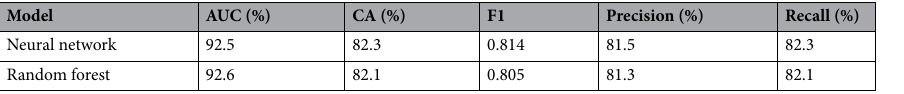
Table 1. Overall performance of the neural network and random forest models across all sleeping stages (average over classes) in terms of area under the curve (AUC), classification accuracy (CA), F1 score, precision, and recall